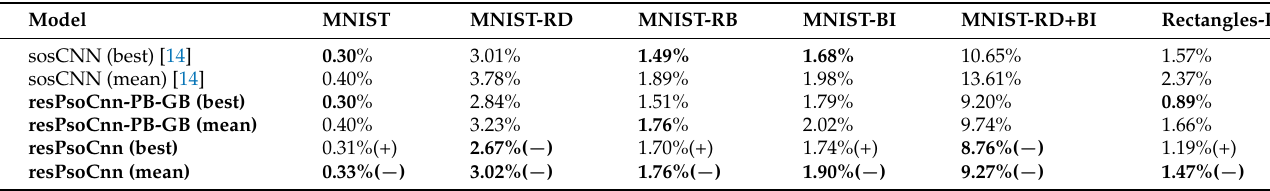
Table 7. Evaluation results of resPsoCnn (the proposed encoding scheme in combination with the proposed search strategy), resPsoCnn-PB-GB (the proposed encoding scheme in combination with the original PSO operation) and sosCNN. Model MNIST MNIST-RD MNIST-RB MNIST-BI MNIST-RD+BI Rectangles-I sosCNN (best)